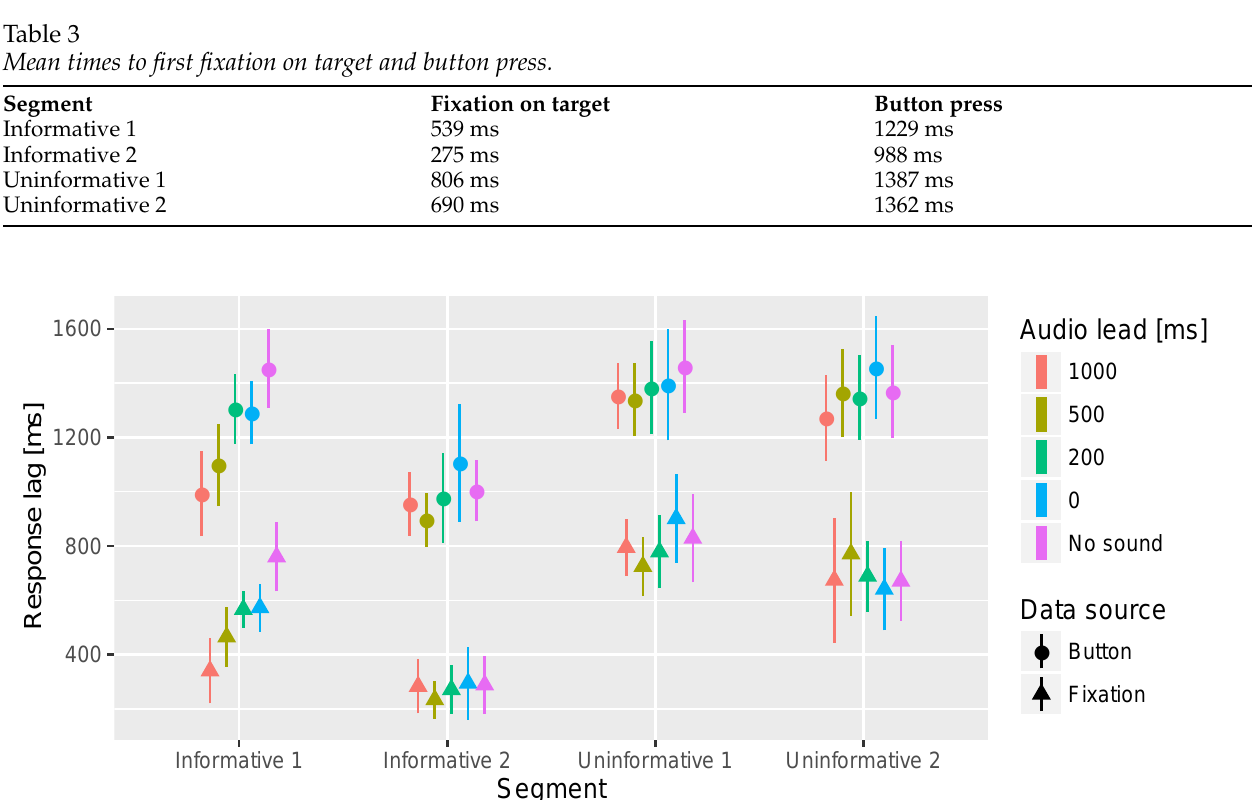
Figure 7 . Mean times to first fixation on target area of interest and button press. In this analysis the data is divided according to the 4 different segments and 5 different audio offsets. The bars represent the 95 % confidence intervals of the